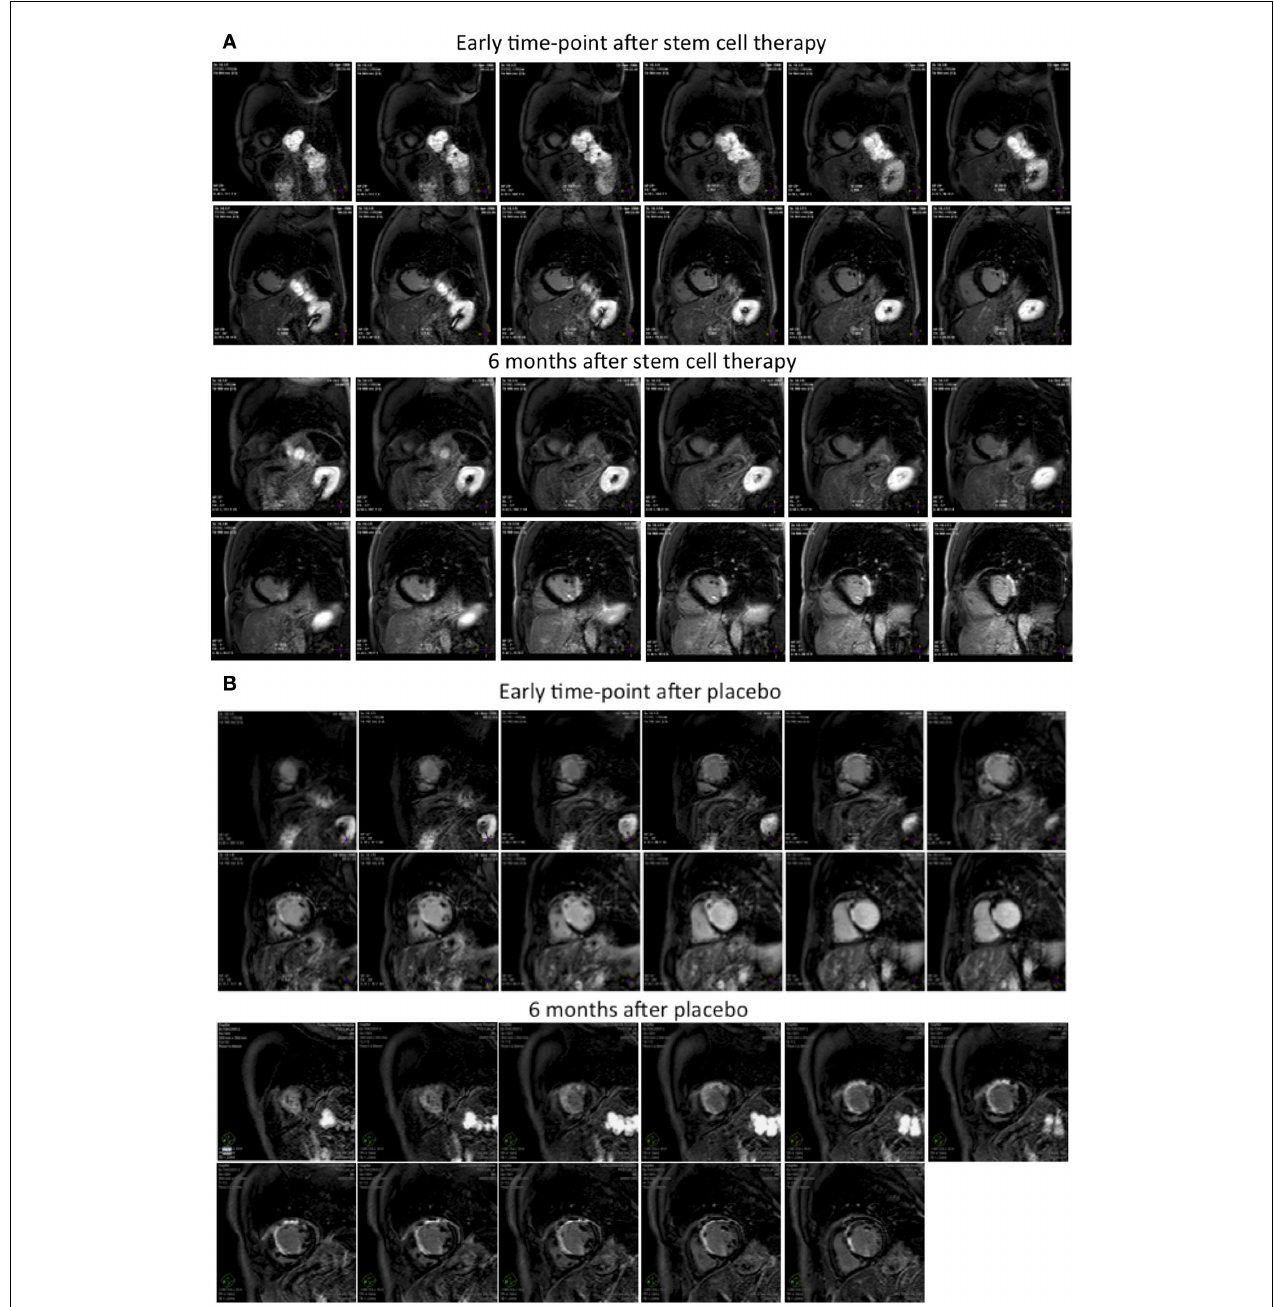
time-points. Patient (A) had infarct size 8.8% at day 10–15 time-point and 11.3% at 6months, and patient (B) infarct size was 40.3 and 31.6% at corresponding